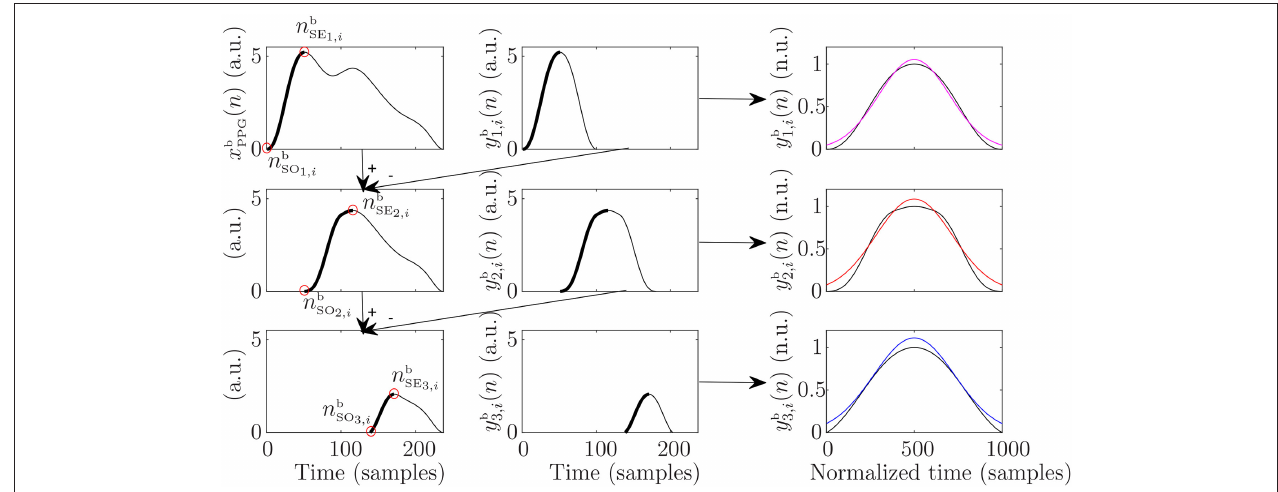
FIGURE 2 | Example of the steps for the pulse decompostion analysis that lead to extraction of main wave (first row), first reflected wave (second row), and second reflected wave (third row). In addition, the subsequent modeling of the extracted waves can be observed in the third column in magenta, red, and blue for the main, first reflected, and second reflected waves, respectively.